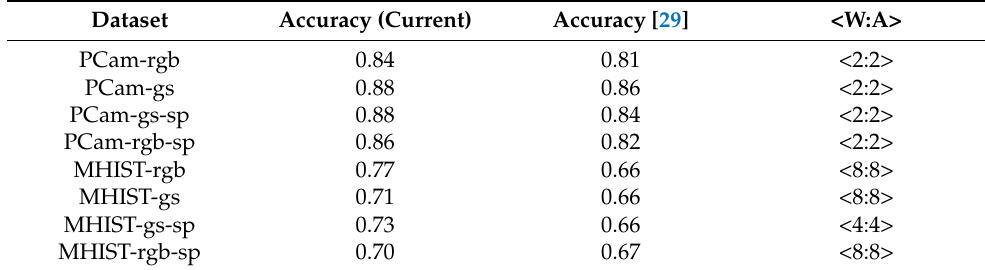
Table 5. Comparison of accuracy results with our previous